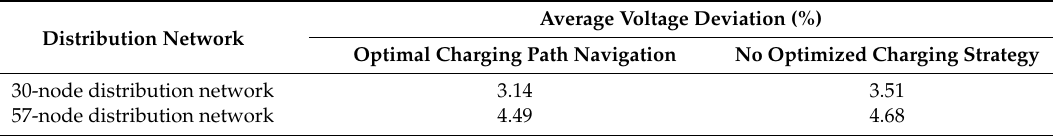
Table 3. Average voltage shift rate.